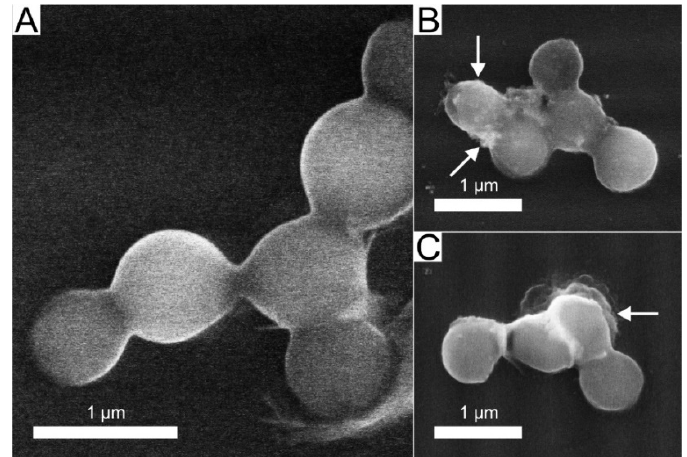
Figure 5. SEM micrographs of silver-treated and untreated S. aureus referential bacteria: ( A )—control (intact), ( B , C )—treated bacteria with silver ions (300 min, 4 ppm), damaged cell walls and cytoplasm leak out observed, are marked with arrows.